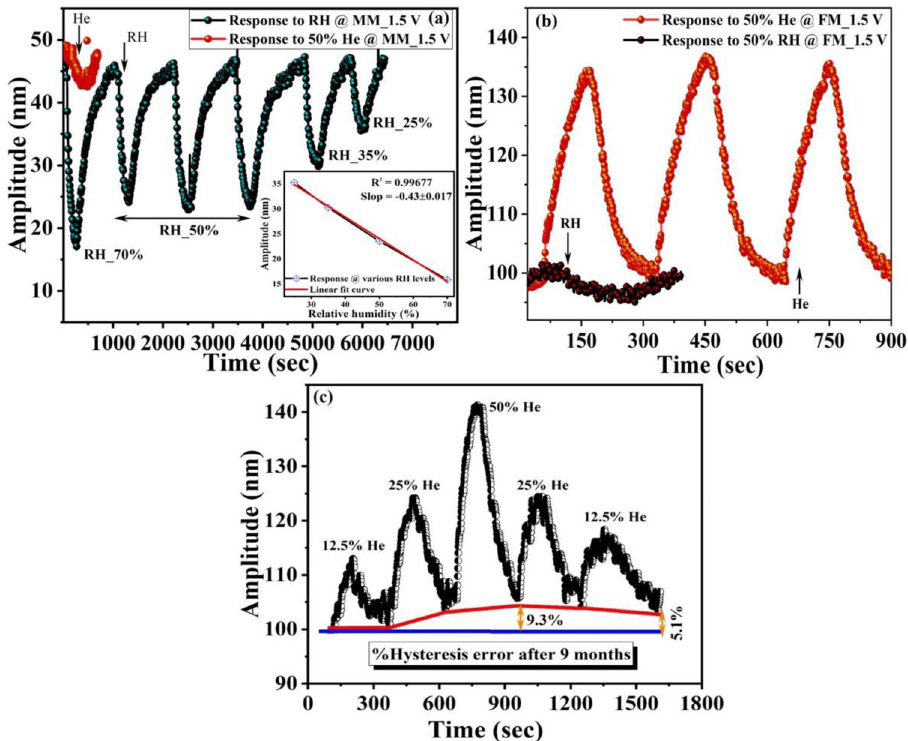
Figure 8. Linearity and repeatability test of the individually actuated vibration modes operated at V ac = 1.5 V, and f o3 = 162.95 kHz (flexural mode), ( a ) response of MM operated at f o1 = 30.67 kHz to different levels of relative humidity with repeatability (single-cycle response of 50% He is also attached), ( b ) repeatability graph for 50% He at FM operated at f o3 = 162.95 kHz. For comparison, a single-cycle response to 50% relative humidity is also shown in the graph, and ( c ) response to different concentration of He at FM after nine months showing the hysteresis test results.